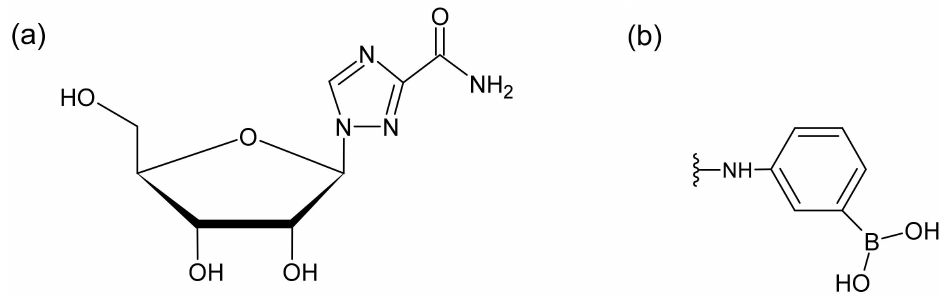
Figure 1. ( a ) Chemical structure of ribavirin. ( b ) Functional group of MonoSpin PBA. Typically, ribavirin is used for therapeutic drug monitoring (TDM). Ribavirin is rapidly absorbed after oral administration (time to maximum concentration = 1.5 h), followed